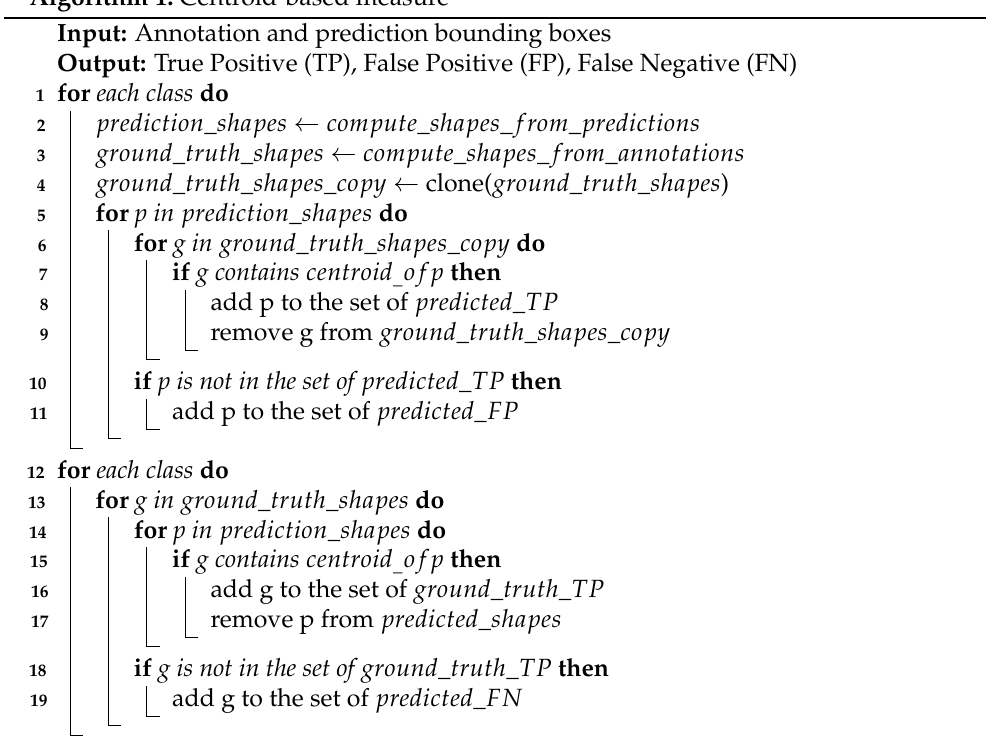
Algorithm 1: Centroid-based